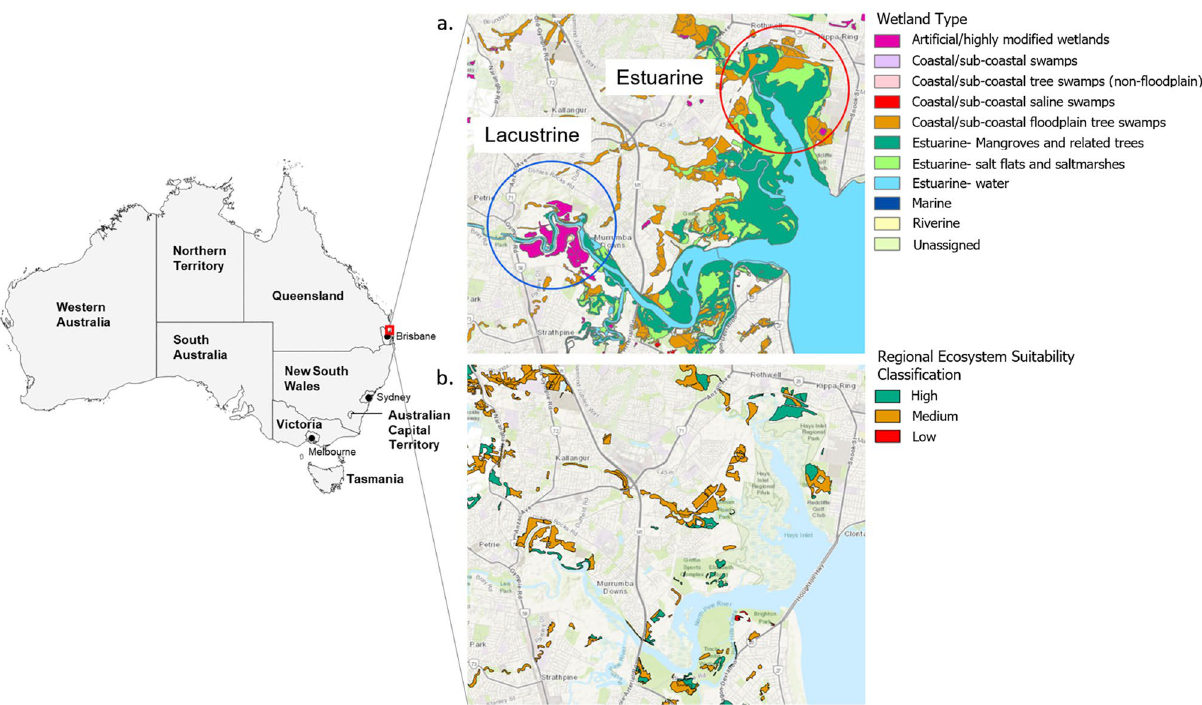
Figure 1. ( a ) Location of the study area in southeast Queensland, Australia, and summary of primary water bodies present in each surveyed environment. ( b ) Location and ecosystem suitability classification of koala habitat in the study area as of the most recent state-wide classification (January 2020) 7 . Wetland 70 and koala habitat 71 GIS shapefiles were obtained through the QSpatial Catalogue (http://qldsp atial .infor matio n.qld.gov. au/). Base layer of the region area sourced from Esri World Imagery 72 . This figure was created using the ArcGIS Pro software suite (version 2.4.2, https ://www.esri.com/en-us/arcgi s/produ cts/arcgi